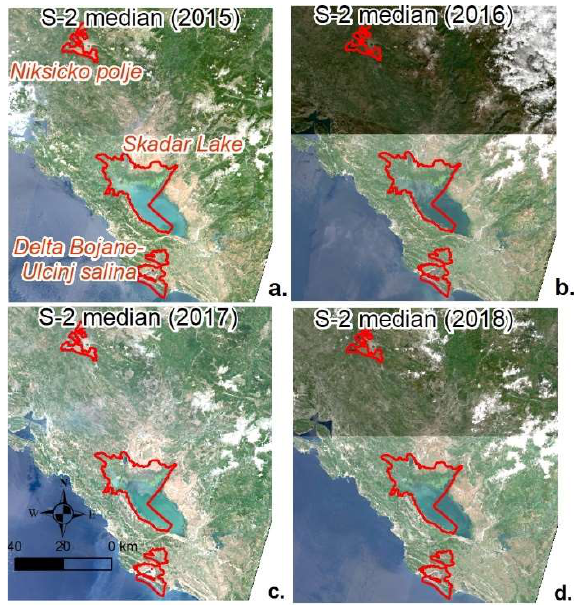
For the second experiment, annual image composites (Figure 3) were generated for 2015,2016, 2017, 2018, and 2019.